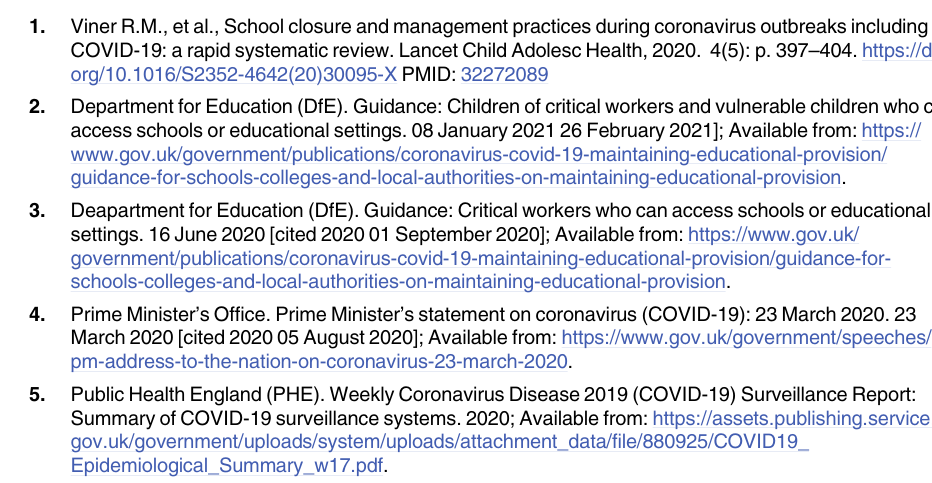
S1 Table. Overall participant return rates by eligible sampling weeks. The first sample week per eligible sample week is 100%, with participation rate the number of returning individuals from this first